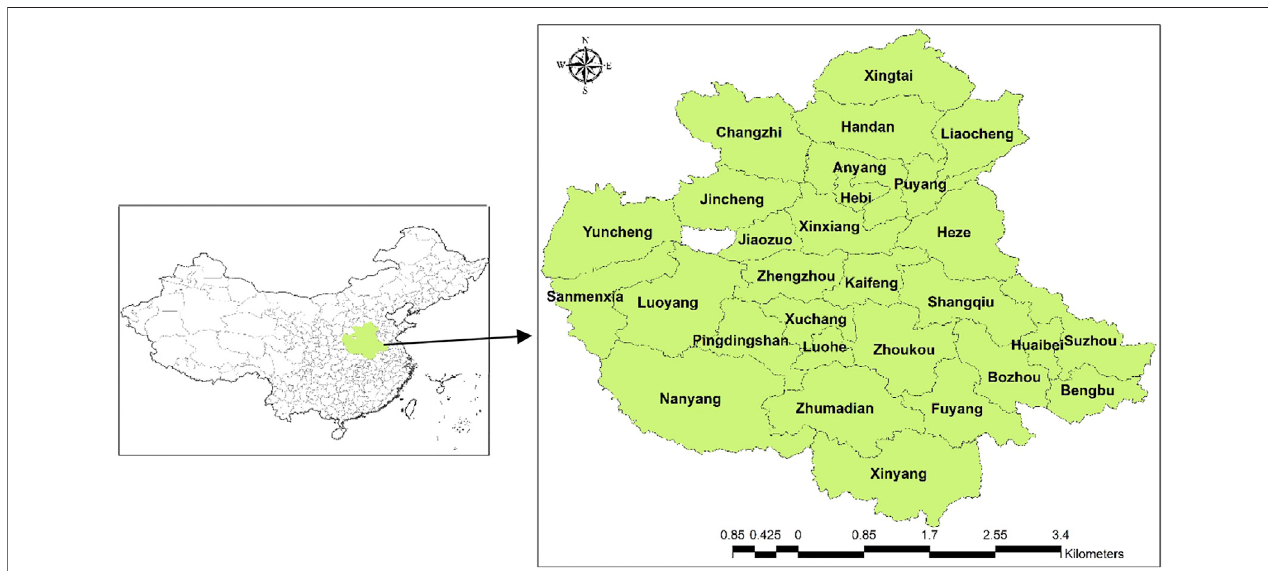
FIGURE 1 | Location of the study area in the